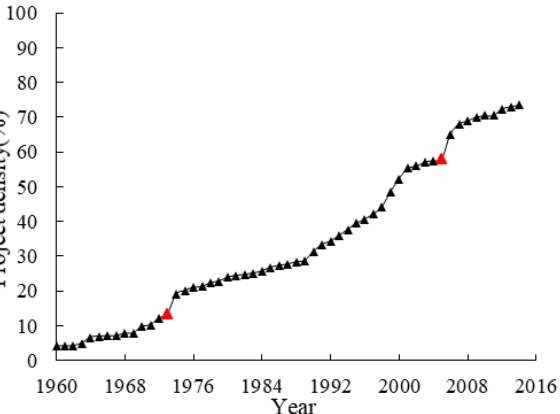
Figure 4. Density of wandering river regulation works in the lower Yellow River from1960 to